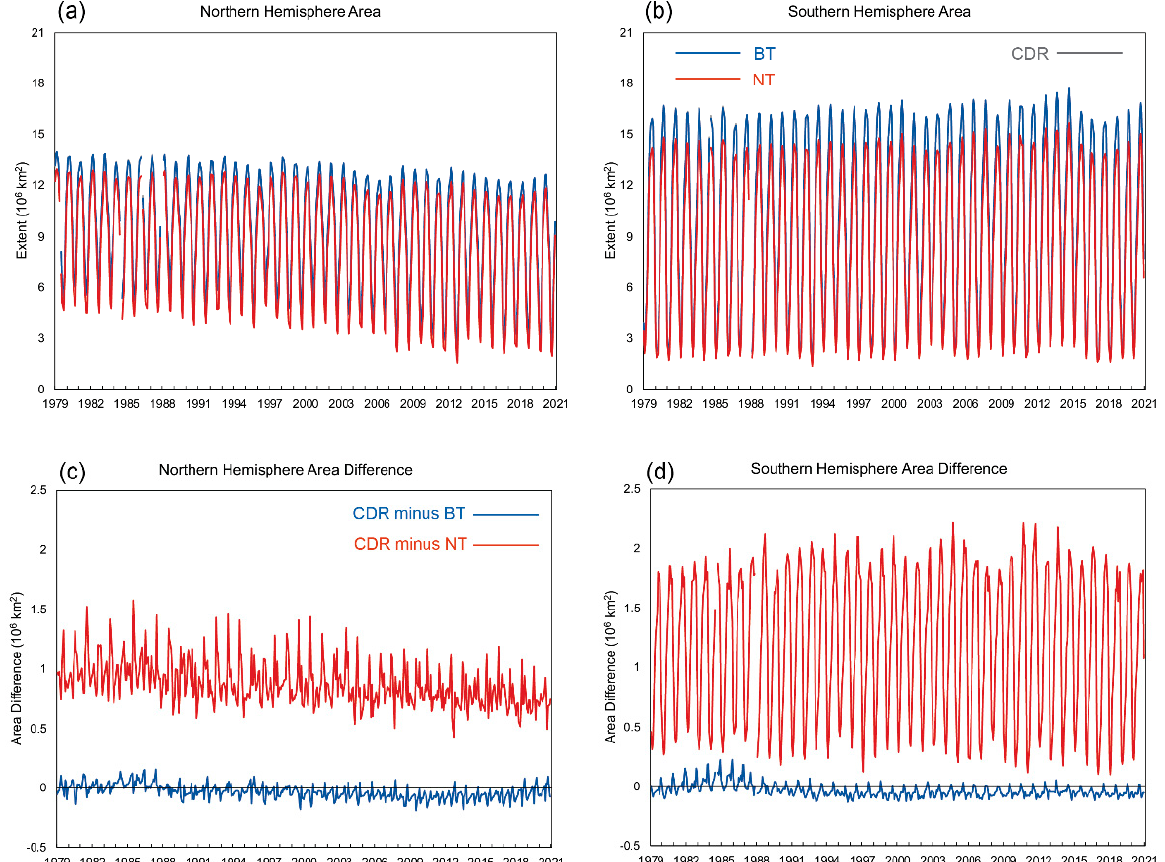
Figure 4. Total monthly sea ice area, 1979–2020 for ( a ) Northern Hemisphere and ( b ) Southern Hemisphere, and CDR–BT and CDR–NT area difference for ( c ) Northern Hemisphere and ( d ) Southern Hemisphere.